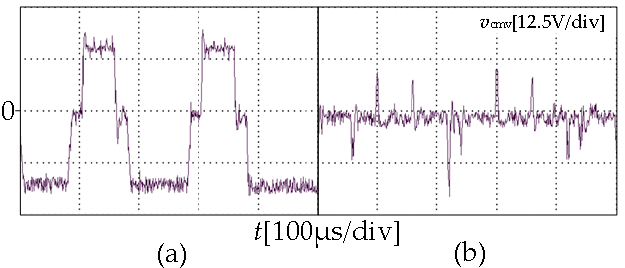
Figure 12. The local magnification of common-mode voltage: ( a ) SVPWM ( b ) 0CMV-SVPWM.